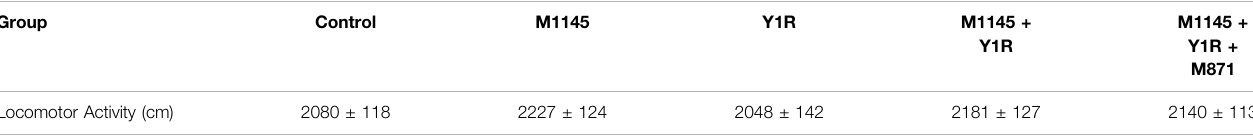
TABLE 2 | Locomotor/spontaneous activity in the Object-in-place task. Data are expressed as mean ± SEM. According to one-way ANOVA, no statistically signi fi cant difference was observed between the experimental groups. Abbreviations: Control = Distilled water; M1145 = Galanin 2 receptor agonist 132 µg; Y1R = Y1R receptor agonist [Leu 31 -Pro 34 ]NPY 132 µg; M1145 + Y1R = Coadministration of M1145 and Y1R; M1145 + Y1R + M871 = Coadministration of M1145, Y1R and GALR2 antagonist M871 132 µg.